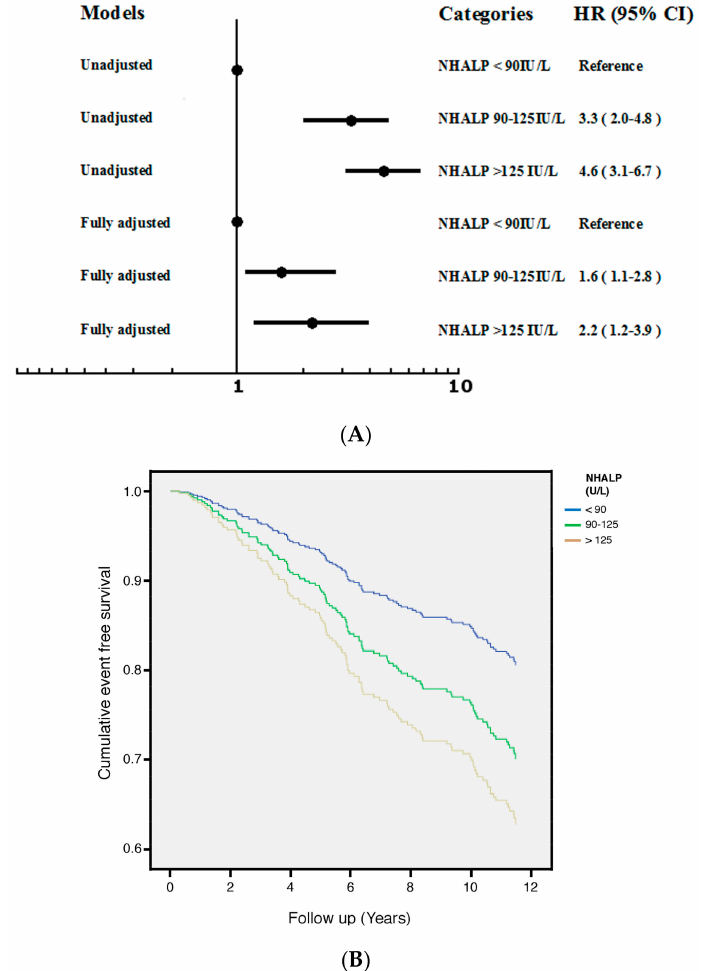
Figure 1. ( A ) Unadjusted and fully adjusted HR of progression of VFs across different categories of NHALP in 516 patients with RA during 4489 person-years of follow-up (Fully adjusted: age, gender, osteoporosis, NHALP, hs-CRP and ESR). The lowest HR group (NHALP < 90 IU/L) served as the reference group. Patients with higher NHALP (>125 IU/L) had the greatest risk of progression of VFs after full adjustments. ( B ) Cumulative survival curves with respect to different categories of NHALP after fully adjusted in the Cox proportional hazards regression